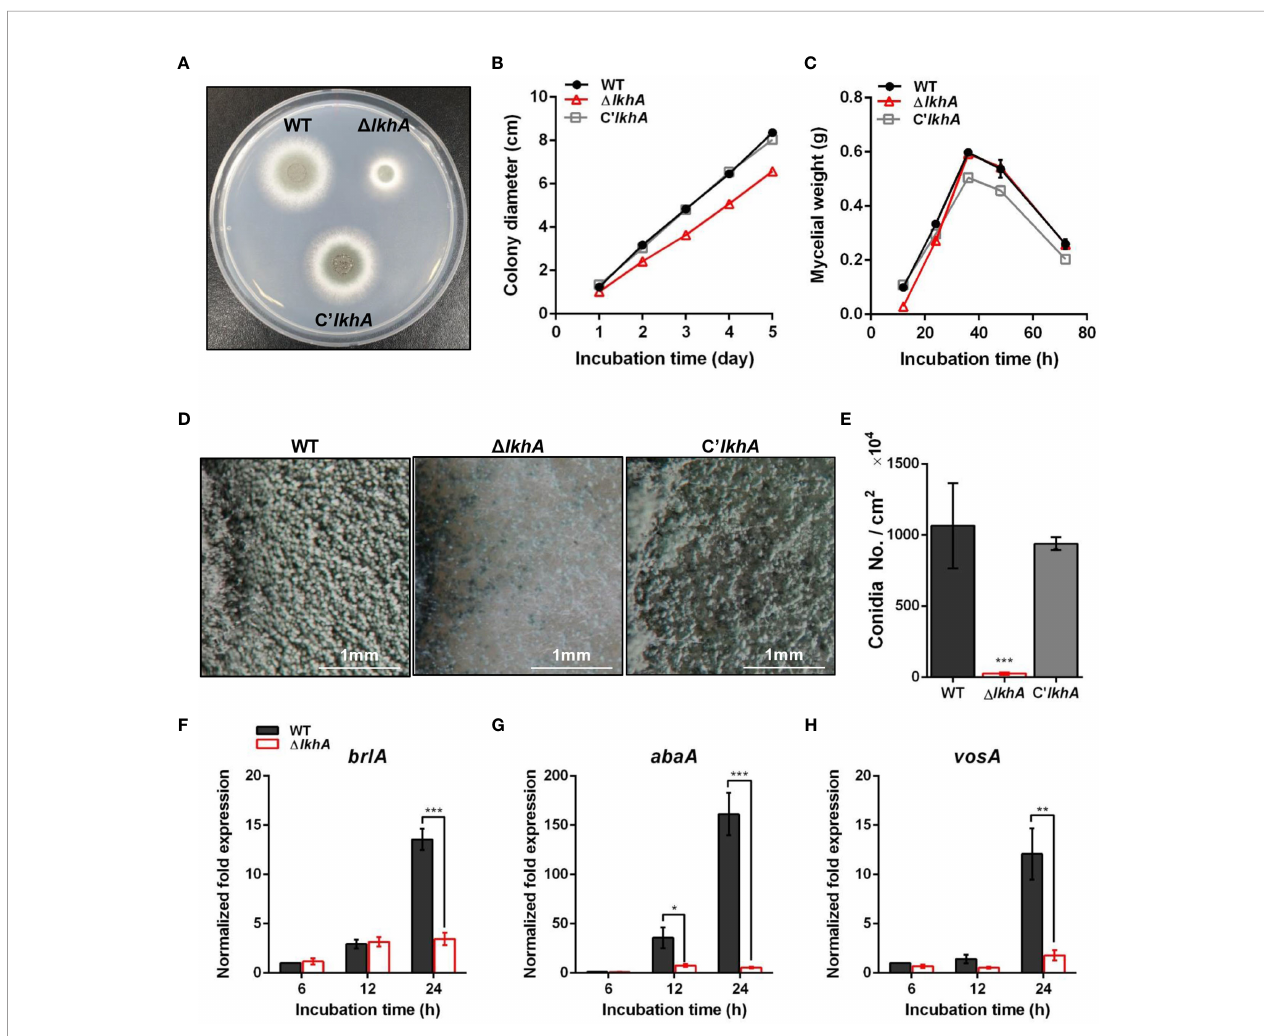
FIGURE 1 | Vegetative growth and asexual development of D A fl khA strain. (A) Colony morphology of WT, D A fl khA , and C ’ A fl khA strains. Spores were inoculated onto GMM agar and incubated at 37°C for two days. (B) Radial growth of WT, D A fl khA , and C ’ A fl khA strains. Colony diameter of each strain was measured daily from point of inoculation over fi ve days. When error bars are not shown, they are smaller than symbols (n = 5). (C) Mycelial production on liquid YCGMM. Dry weight of each strain was measured. When error bars are not shown, they are smaller than symbols (n = 3). (D) Conidiophore heads on GMM agar. (E) Quanti fi cation of conidia production (n = 4). *P < 0.05. (F-H) Expression patterns of brlA (F) , abaA (G) and vosA (H) genes. Mycelial balls of strains obtained from YCGMM liquid culture were transferred to GMM agar and incubated for indicated hrs. Total RNA was extracted and RT-qPCR analysis was performed using 18S rRNA gene as an internal control. **P < 0.01, ***P <